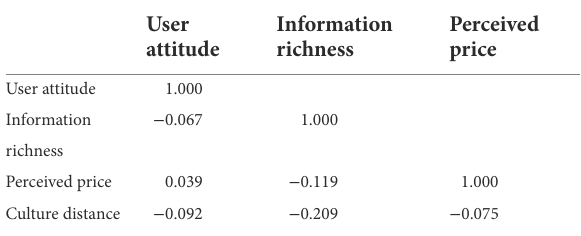
TABLE 2 Correlation